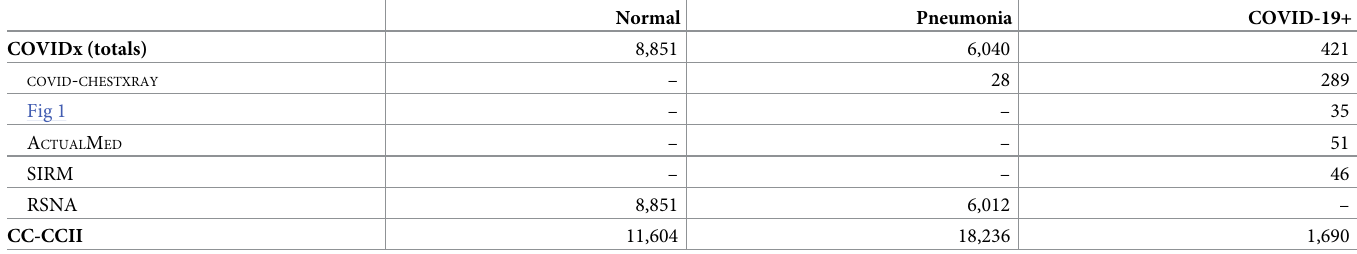
Table 1. Dataset overview. Counts of disease label type per dataset. The COVIDx dataset is made up of 5 sub-datasets and the CC-CCII dataset is used as a held-out test set.